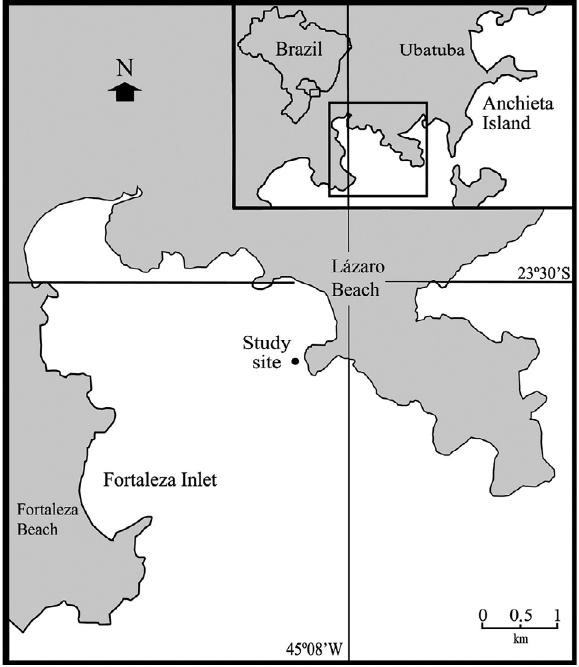
Fig. 1. – Map of Brazil with details of the Lázaro Beach in the Ubatuba region, southeastern Brazil (Adapted from Garcia et al.,